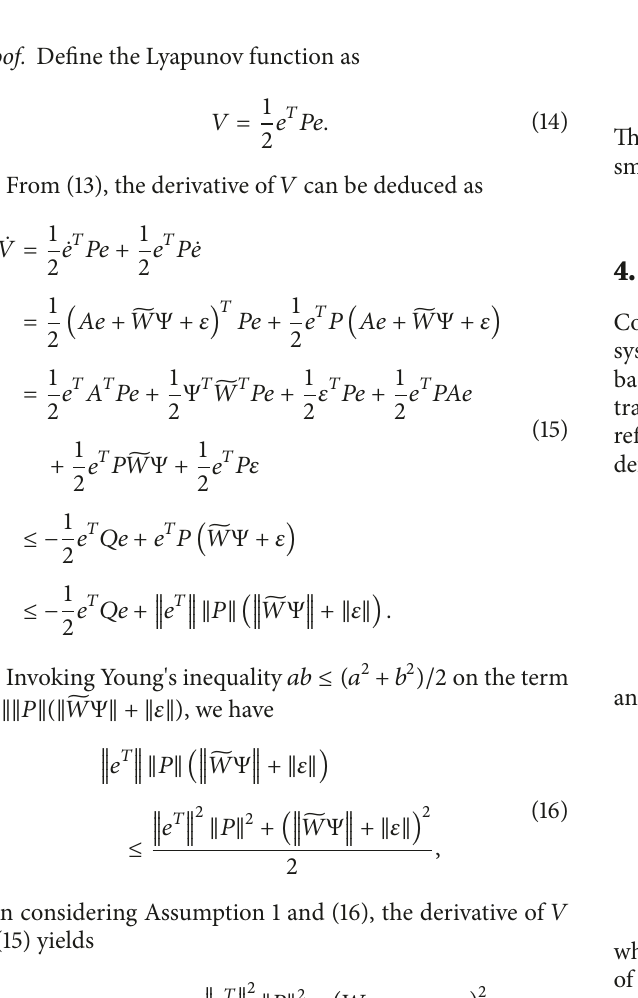
Figure 2: The structure of the NN